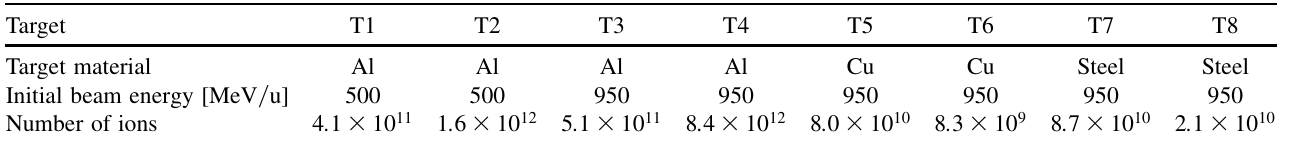
TABLE I. Irradiation conditions and total numbers of ions delivered to the targets.